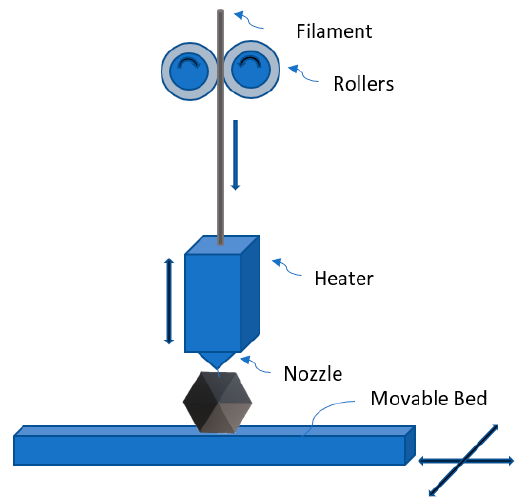
Figure 1. Process Schematic diagram for FDM Process.